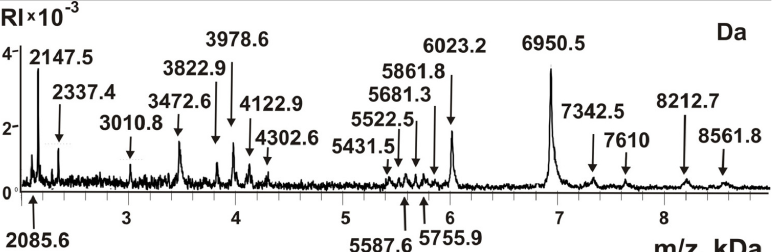
Figure 4. MALDI spectra of peptides and small proteins of sea cucumber complex. The fraction of peptides and small proteins was prepared by dissociation of the complex by trifluoroacetic acid in dioxane and its filtration through filters passing compounds with a MMs s <10 kDa. See Materials and Methods for other